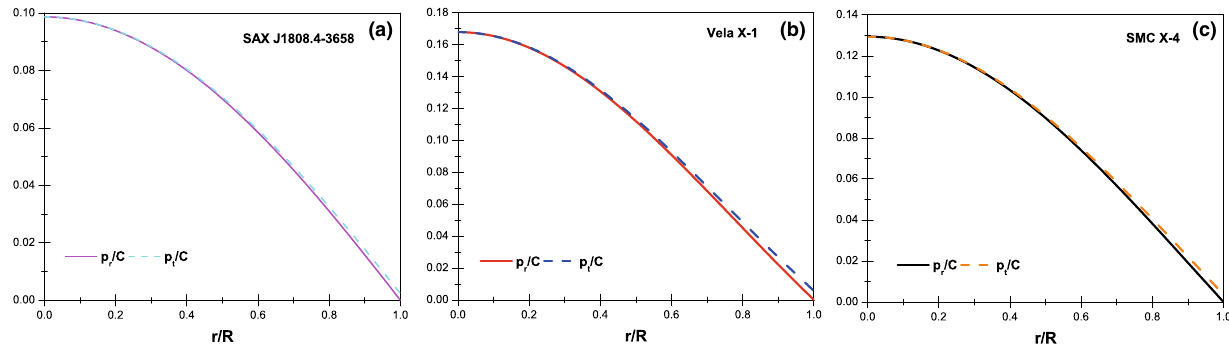
Fig. 8 Comparison between the radial and the tangential pressures for α = 0 . 3